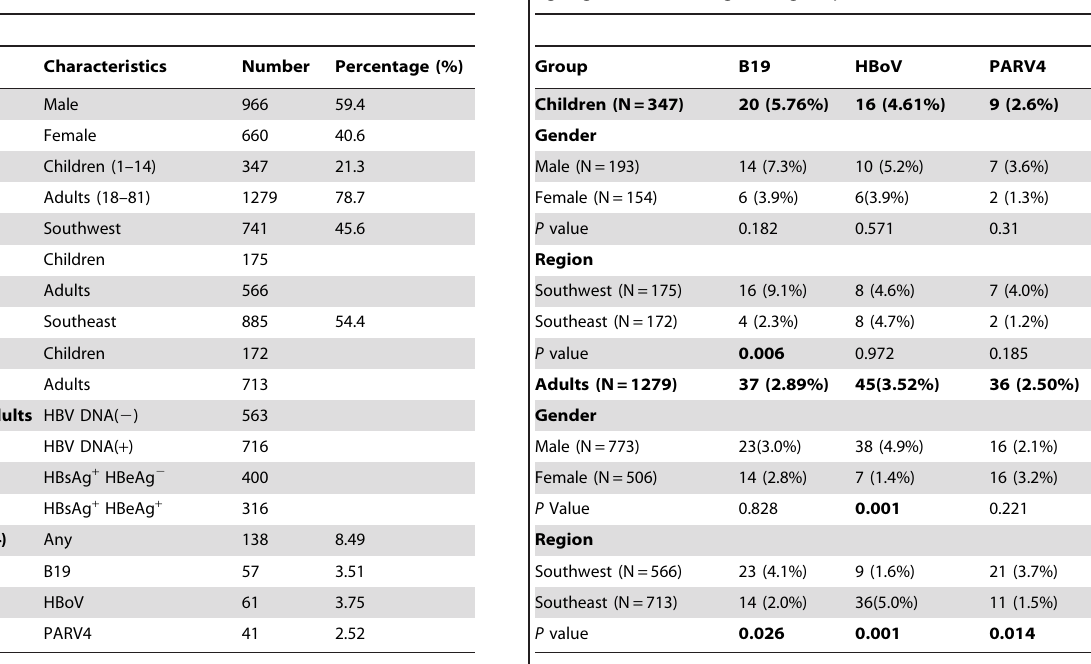
Table 1. Demographic characteristics of all participants (N= 1626).